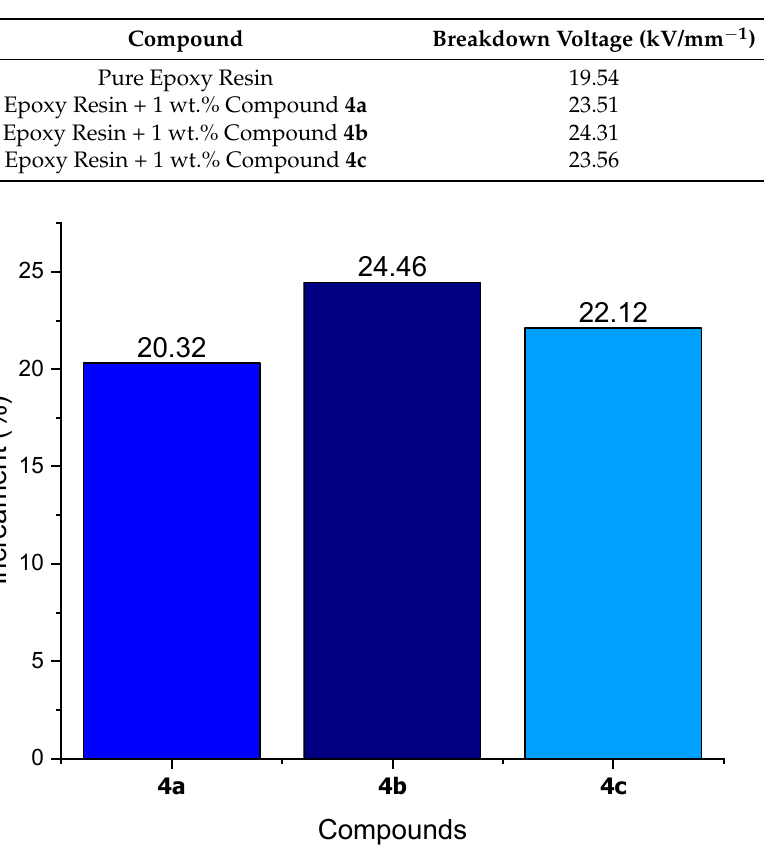
Table 4. Breakdown voltage of the compounds.